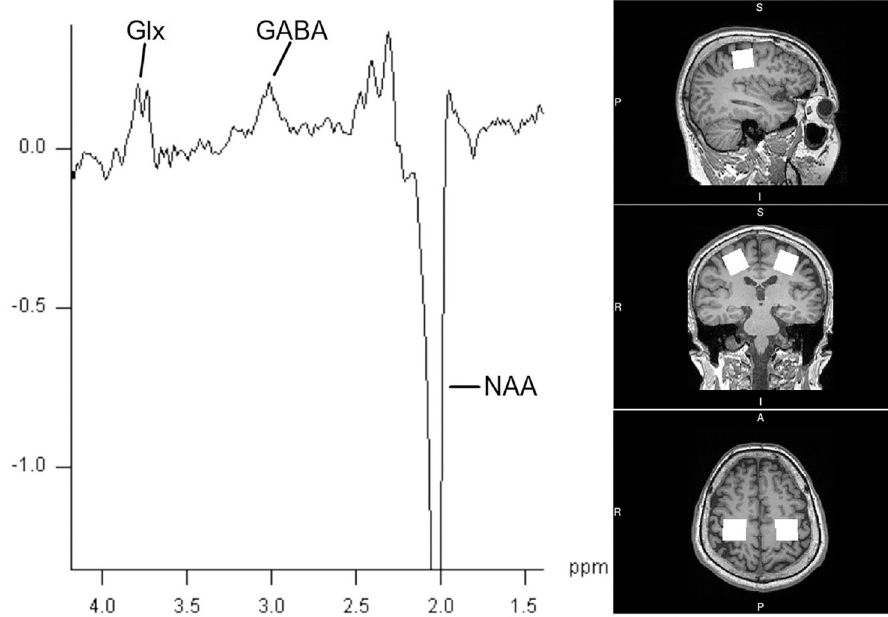
Fig 2. A typical GABA-MRS spectrum, where peaks of GABA, NAA, and combined glutamate and glutamine (Glx) are measured. A voxel measuring 25 × 25 × 25 mm placed in bilateral M1 of a typical subject.